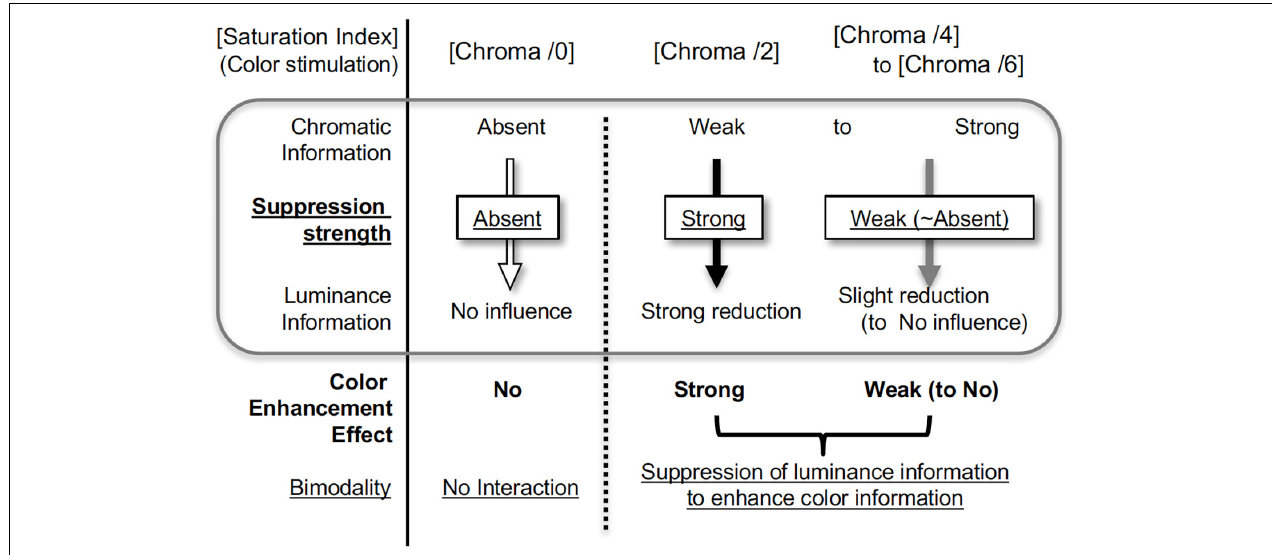
FIGURE 13 | Scheme of color enhancement